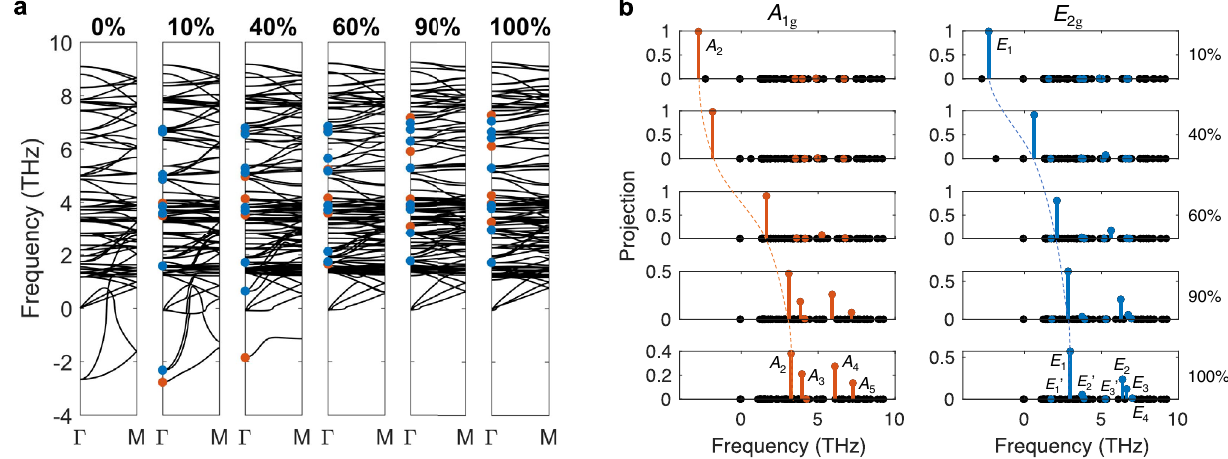
Fig. 3 Phonon band structures and mode mixing in the process of CDW distortion. a Phonon band structures directly calculated by DFT. Here, 100% (0%) refers to the fully stable ISD (2 × 2 pristine) structure. 10% refers to the intermediate structure with 10% distortion from the pristine to ISD phases. After 2 × 2 × 1 band folding with no distortion, three imaginary modes ( M þ ) are folded to Γ . A weak ISD-type distortion lifts the degeneracy and leads to A 1g 1 and E 2g modes. The ISD distortion gradually transforms imaginary modes to real. b Projections of the imaginary A 1g ( E 2g ) mode with 10% distortion to all the other phonon modes at Γ , as evolving into the stable ISD phase (100%). We highlight all A 1g and E 2g modes by orange and blue dots, respectively, at the Γ point. The dashed orange (blue) curve in ( b ) guides eyes to show the evolution of the imaginary A 2 ( E 1 ) modes in the CDW measurable in Raman. Only when CDW appears, they come out as amplitude modes, characterizing the CDW transition. With CDW distortion, they decompose to a singlet A 1g mode and a doublet E 2g mode under the point group D 6h (see Supplementary Note 3):